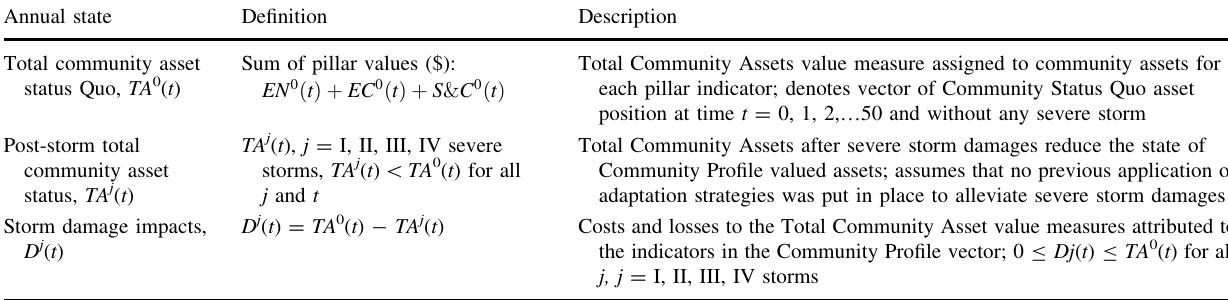
Table 5 System dynamics model Base Case output state